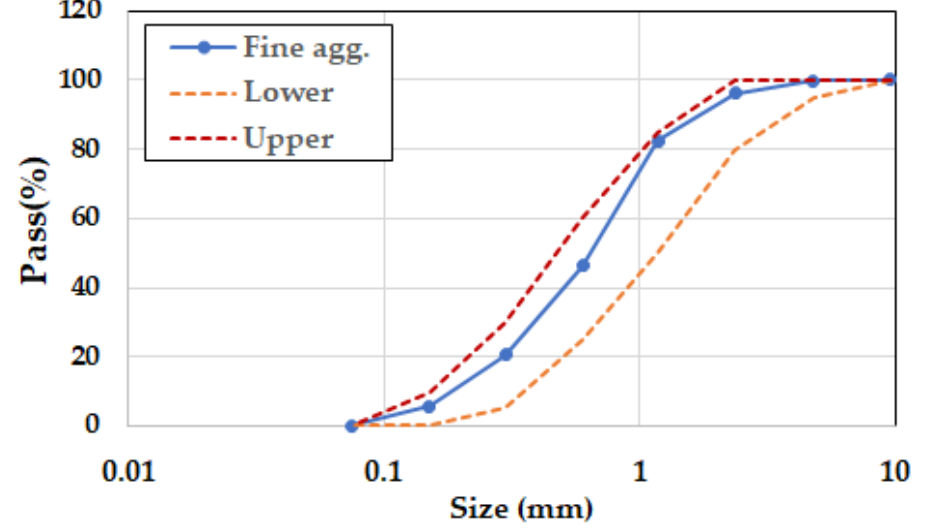
Figure 2. Grading of fine aggregate. Table 4. Properties, requirements and test results for fine aggregates [36–42].